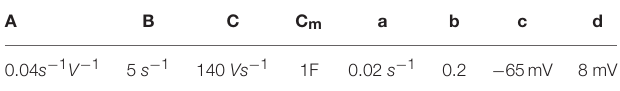
TABLE 1 | Izhikevich neuron model